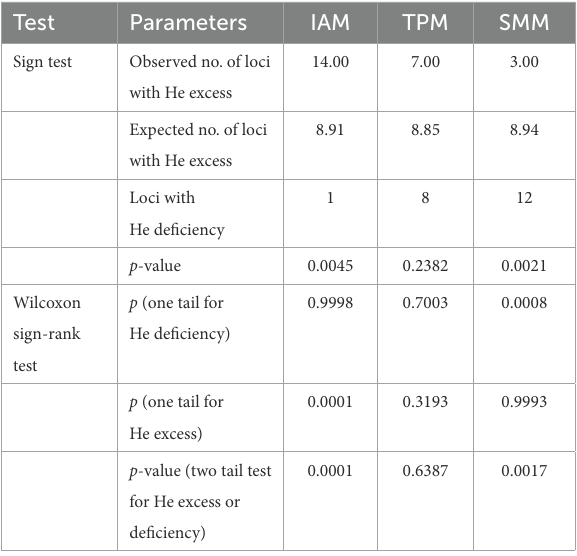
TABLE 6 Mutation-drift equilibrium and heterozygosity excess/ deficiency under different mutation models for the Jankowski’s Bunting